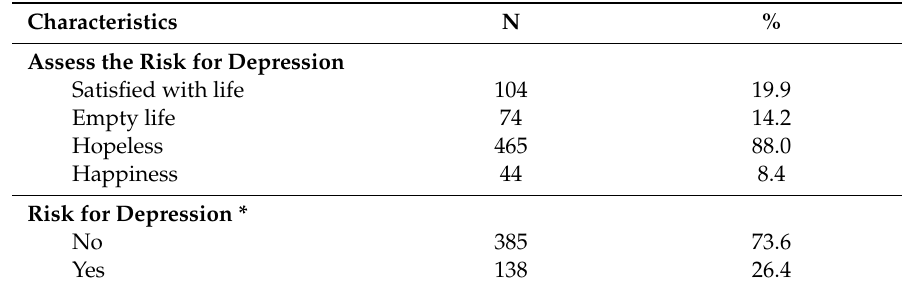
Table1. RiskfordepressionamongolderpeoplebasedontheGeriatricDepressionScale-4items(GDS-4). Characteristics